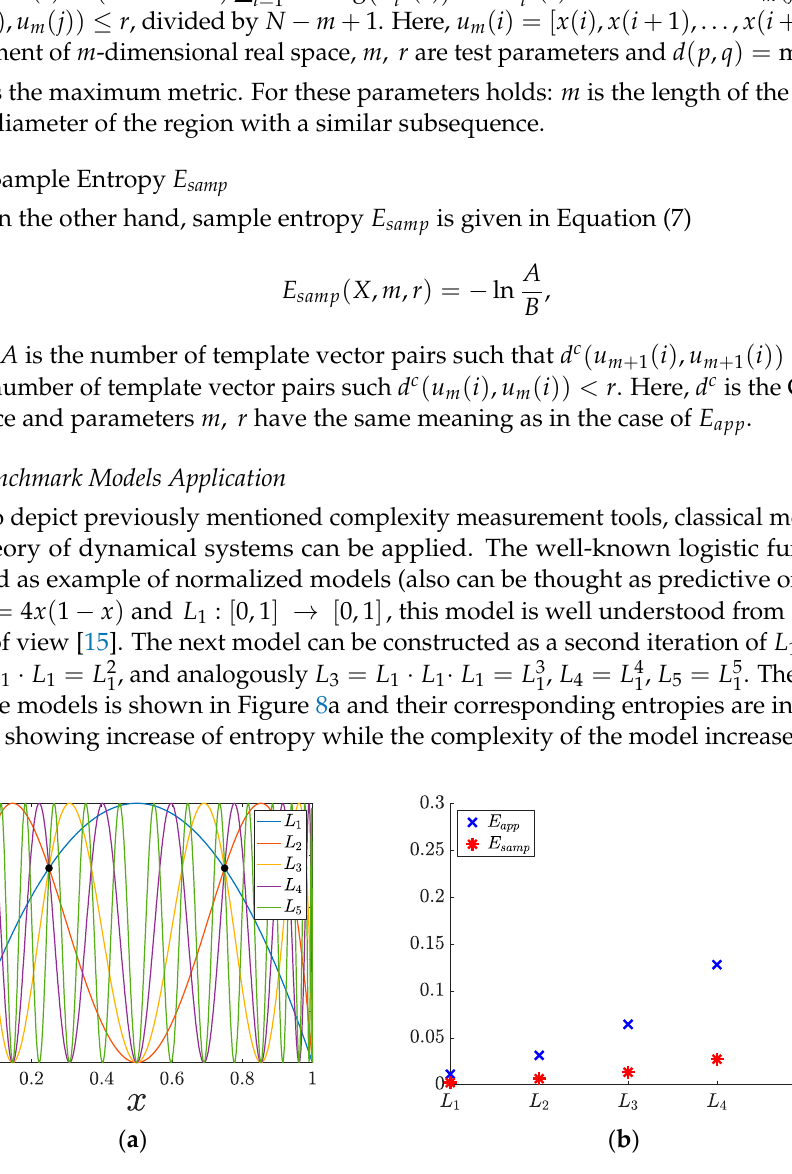
Figure 8. Benchmark models’ L i evolution in ( a ) and corresponding entropies in ( b